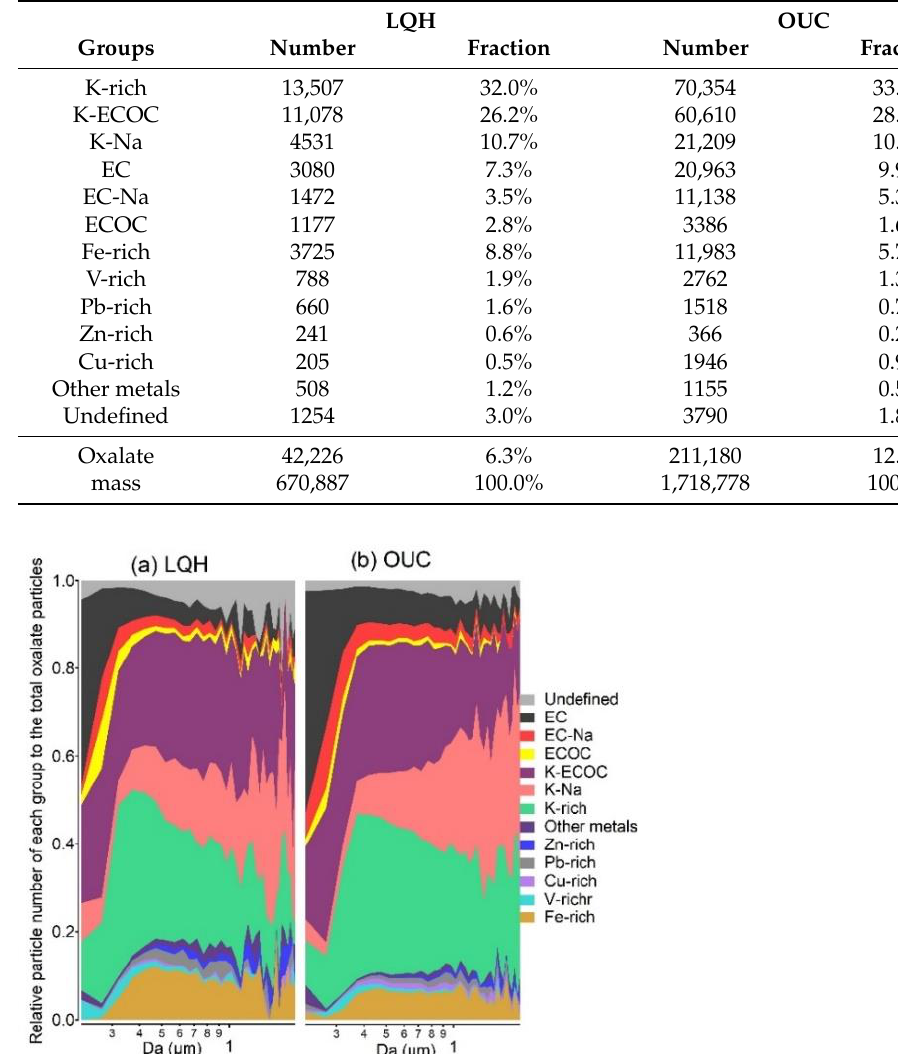
Table 2. Groups of oxalate particles classified according to the Art-2a method.